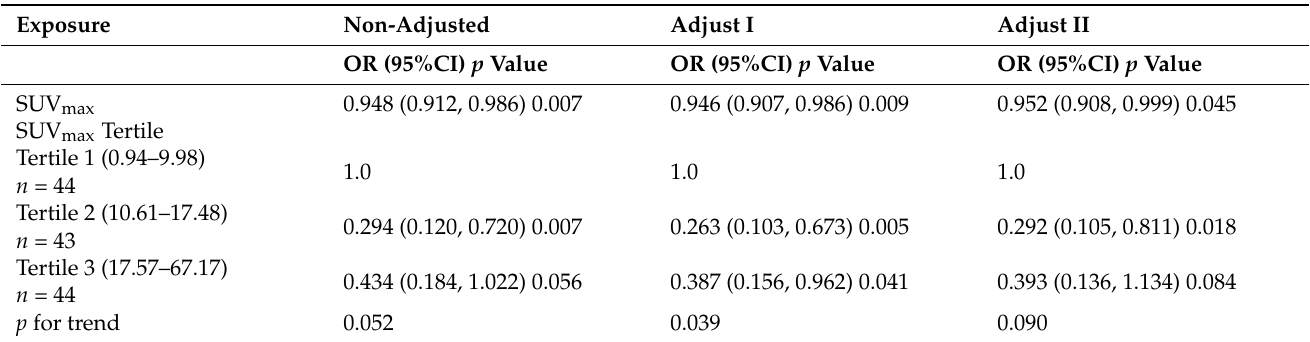
Table 2. Multivariable regression for the association between SUV max and EGFR mutation probability in smoking subgroups.